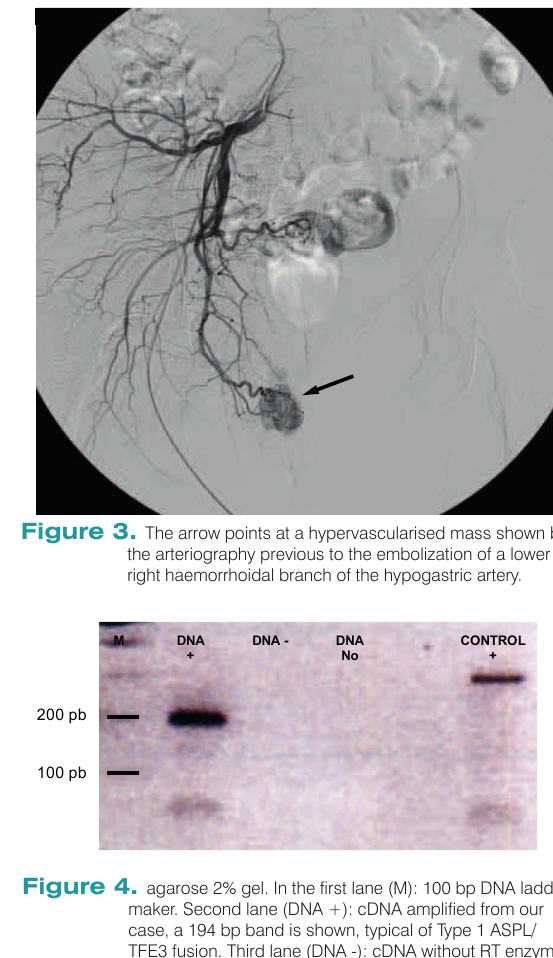
Figure 2. Immunohistochemistry: actin, vimentin and myoD posi- tivity and TFE 3 negativity.